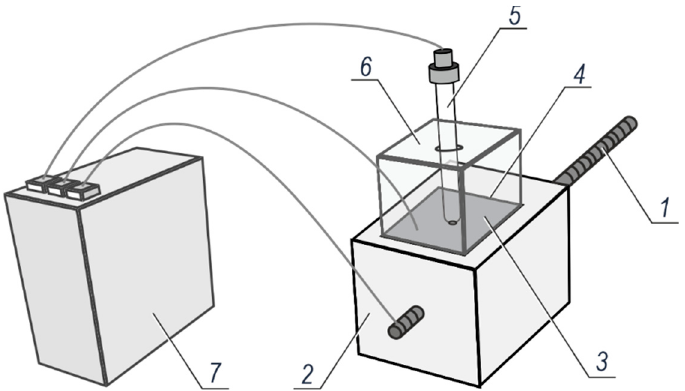
Figure 6. The test set-up used for the polarization tests of corrosion rate in concrete reinforcement: 1 —steel rebar, 2 —concrete specimen, 3 —counter electrode made of stainless steel sheet, 4 —felt pad, 5 —reference electrode Cl – /AgCl,Ag, 6 —ballast with a guide for the reference electrode, 7 —potentiostat.